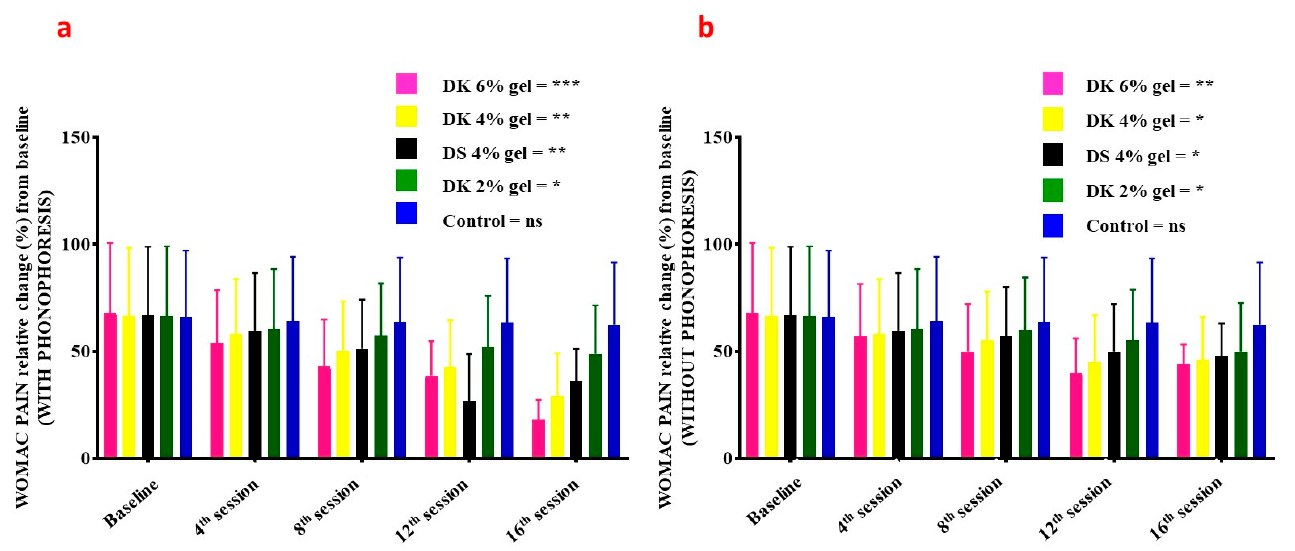
Figure 6. Index of WOMAC pain on the baseline, 4th session, 8th session, 12th session, and 16th session of Diclofenac potassium (DK) treatment ( a ) with phonophoresis ( b ) without phonophoresis, in sports-injured patients. Diclofenac sodium (DS) was used as a standard control. Control group is the placebo. Statistical significance ( p -values) is detailed in the main text. ns = no significant; p < 0.05 *, p < 0.01 **, p < 0.001 ***. WOMAC: Western Ontario and McMaster Universities Arthritis Index.